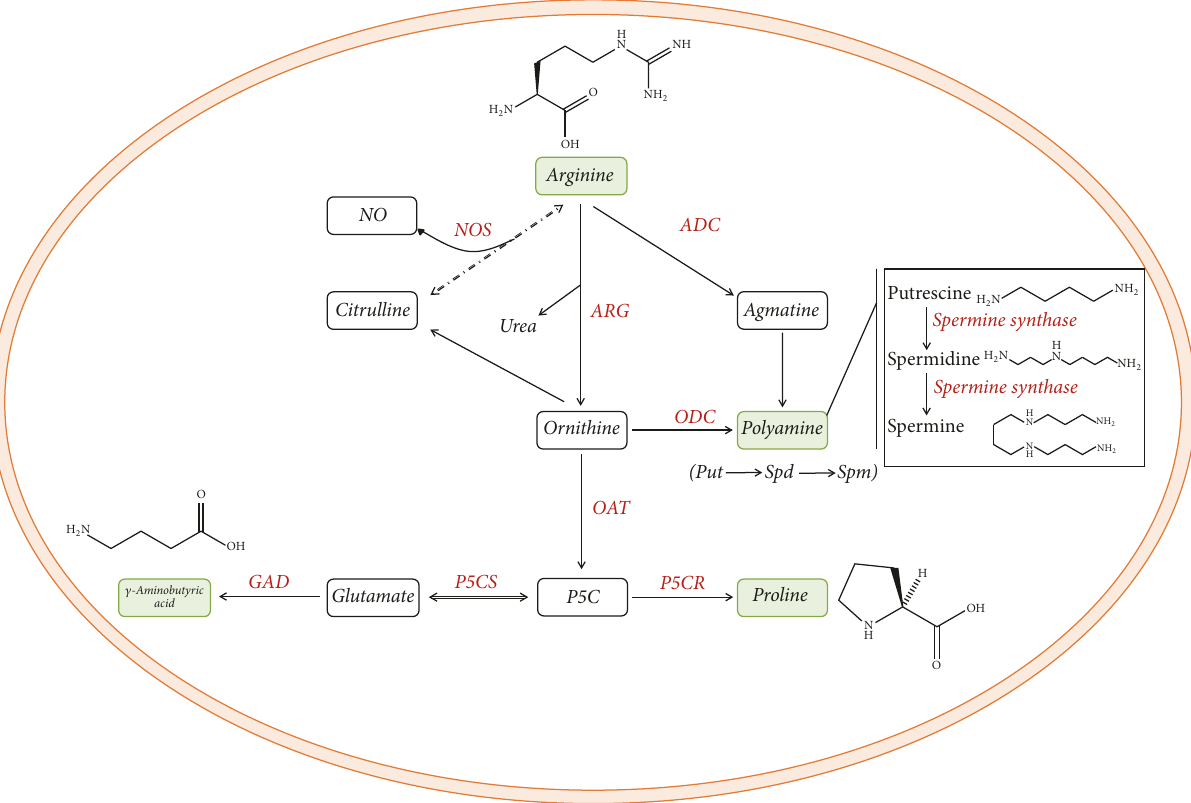
Figure4:Argininepathwayswhichleadtotheproductionofpolyamines,proline,and 𝛾 -aminobutyricacid[52,75].Enzymeabbreviationsare as follows: ADC, arginine decarboxylase; ARG, arginase; GAD, glutamate decarboxylase; NOS, NO synthase; ODC, ornithine decarboxylase; P5CR, pyrroline-5-carboxylate reductase; P5CS, pyrroline-5-carboxylate